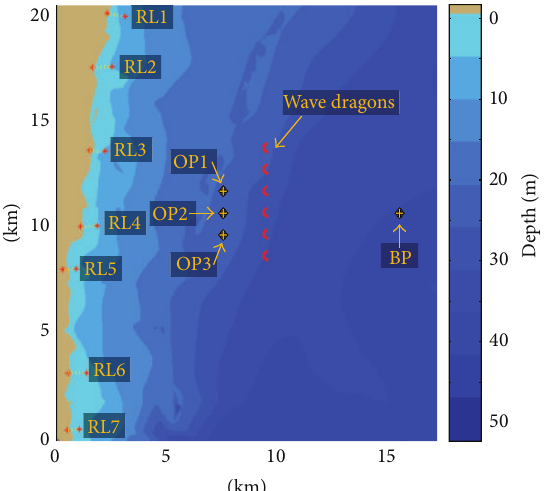
Figure5: Thecomputationaldomainconsideredforthesimulationswithnumericalmodels. Inthebackgroundthebathymetryisrepresented while in the foreground the Wave Dragon, the reference points, and the reference lines. BP indicates the boundary point, OP are the offshore points, and RL represent the reference lines considered in the analysis of the nearshore currents. Each offshore extremity point of the above reference lines is denoted as NP (nearshore point).